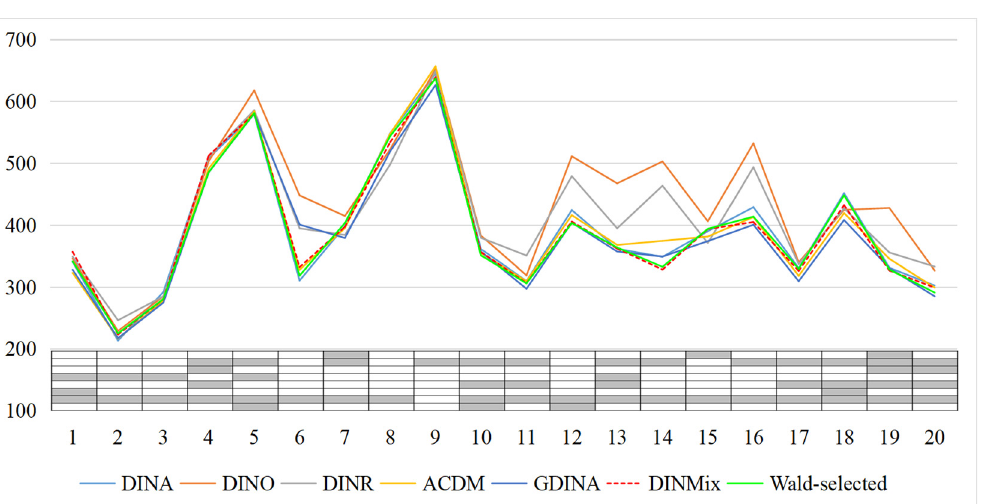
Figure 9. The estimated item parameters for the fraction subtraction data from the DINMix models. Note: g = guessing parameter; s = slip parameter; τ 1 = item-level mixing proportion parameter for the conjunctive condensation rule; τ 2 = item-level mixing proportion parameter for the disjunctive condensation rule; τ 3 = item-level mixing proportion parameter for the ratio condensation rule; DINMix = deterministic input, noisy mixed model. 6. Summary and Discussion The condensation rule describes the logical relationship between the required attrib- utes and the item response, reflecting the explicit assumption about respondents’ cogni- tive processes to solve problems. When an item contains coexisting condensation rules, the contribution of required attributes to the correct item response probability follows multiple condensation rules with different proportions. Coexisting condensation rules re-